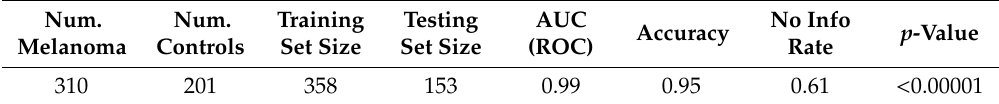
Table 10. SVM method applied to the tissue-expression dataset. Sex and age were not considered as predictors for the lack of data in the dataset. The p , i.e., the probability that the “Accuracy” value is not significantly higher than the “No Info Rate” value, is lower than 0.00001. Hence, we can safely reject the null hypothesis and we can assume that the accuracy of the predictive model is higher than the value of the No Info Rate (0.61), corresponding to the performance of a dummy, fixed-answer predictor.